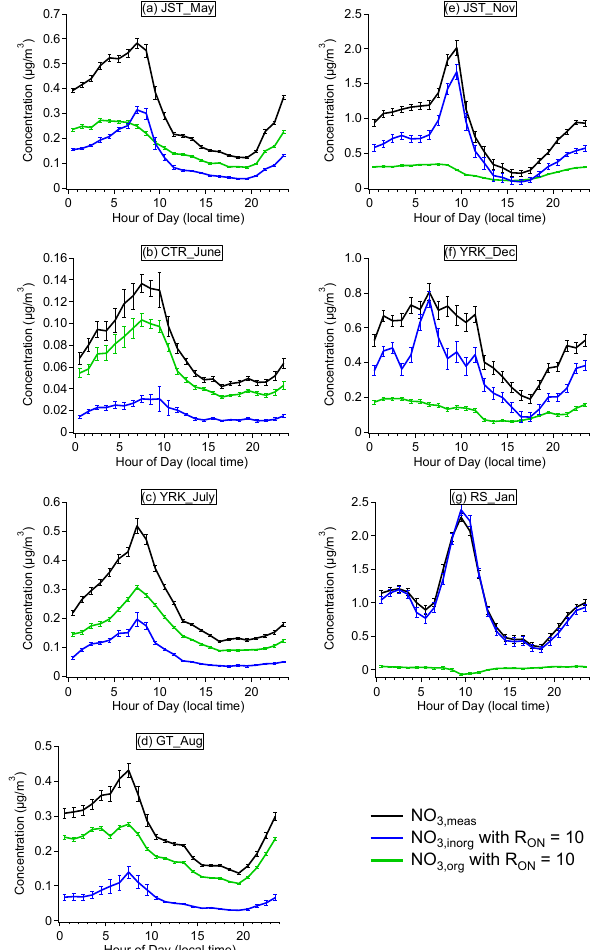
Figure 12. Diurnal variation of NO 3 , meas , NO 3 , org , and NO 3 , inorg for all data sets. NO 3 , org and NO 3 , inorg are estimated by the NO + x ratio method with an R ON value of 10. The solid lines indicate the median concentration and the error bars indicate the standard